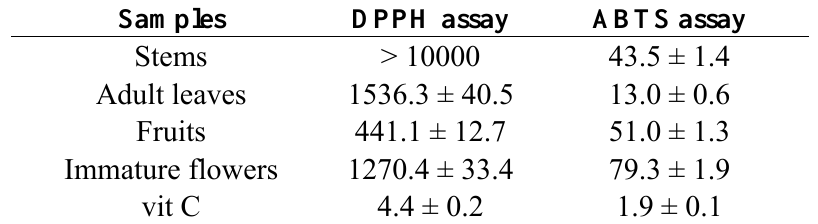
(mg/L)) of the different parts of E. oleosa essential 50